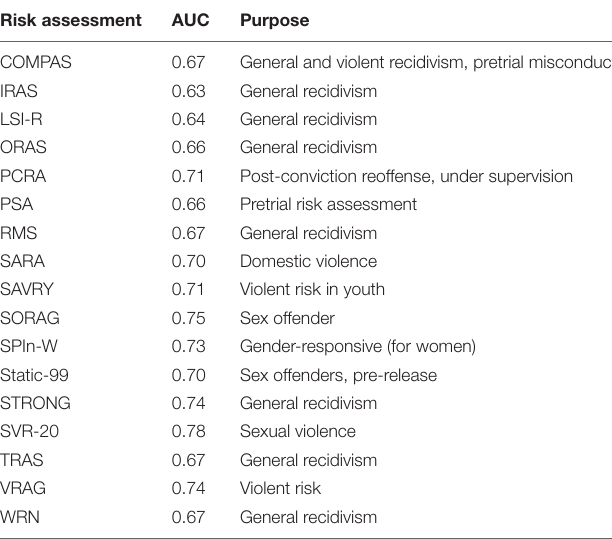
TABLE 1 | Commonly used risk assessments, their stated purpose, and their median area under the curve (AUC) (Singh et al., 2011; Desmarais et al.,